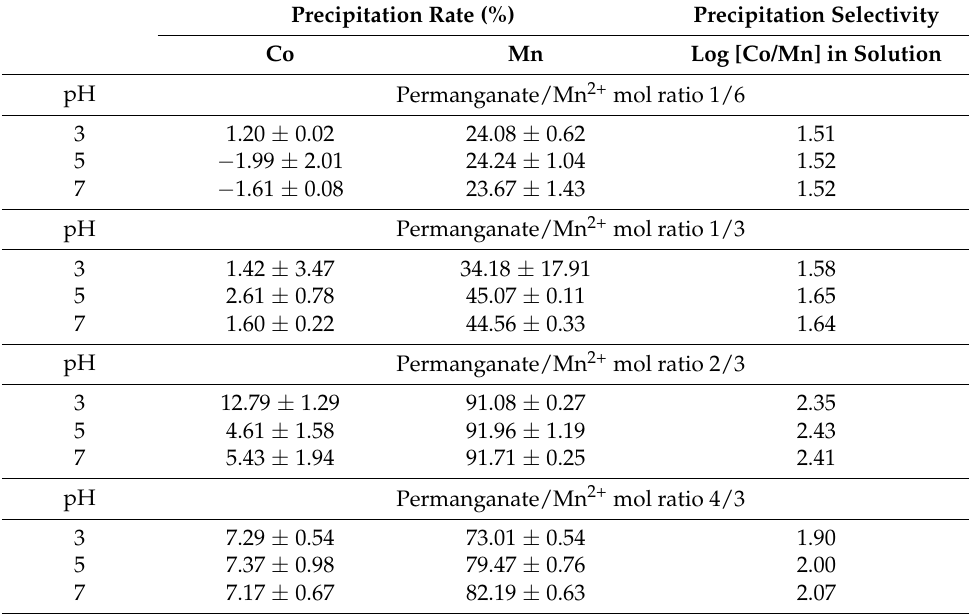
Table 9. The precipitation rate and selectivity of Co and Mn using potassium permanganate based on mol ratio of permanganate/Mn and initial pH of the strip solution. Precipitation Rate (%)